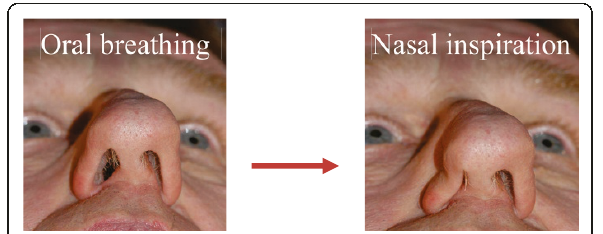
Figure 4 Inspection of the nose showing alar collapse during inspiration